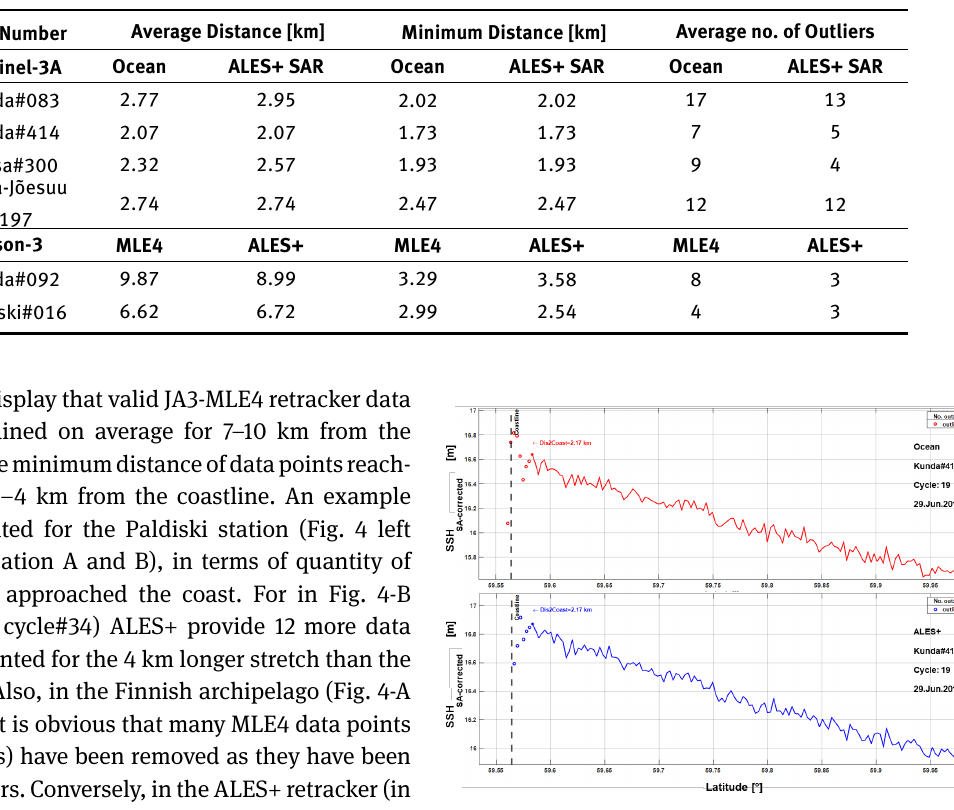
Table 3: Average and minimum distances from the first valid SA data point to the nearest coastline (km) after removing outlier data, for each satellite track.